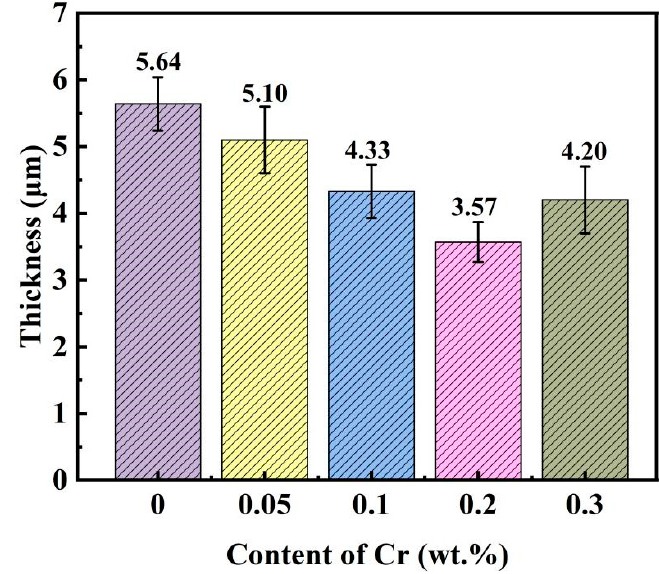
Figure 5. Thickness bar chart of IMC layers at the interface. Figure 6 is the EPMA image of the soldering interface of Sn-0.7Cu-10Bi-0.2 wt.% Cr